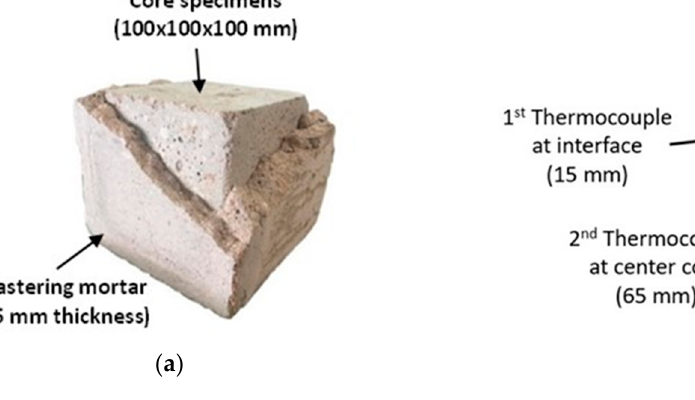
Figure 1. ( a ) Plastered specimen and ( b ) location of thermocouples. Table 3. Mixture proportions for plastered specimens.